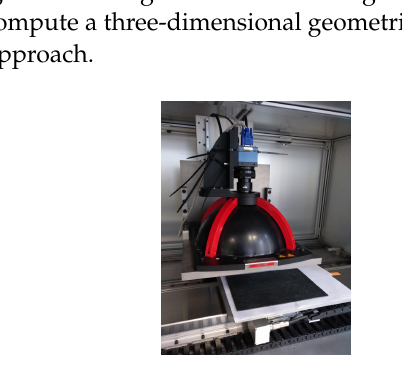
Figure 2. Photometric-stereo image acquisition